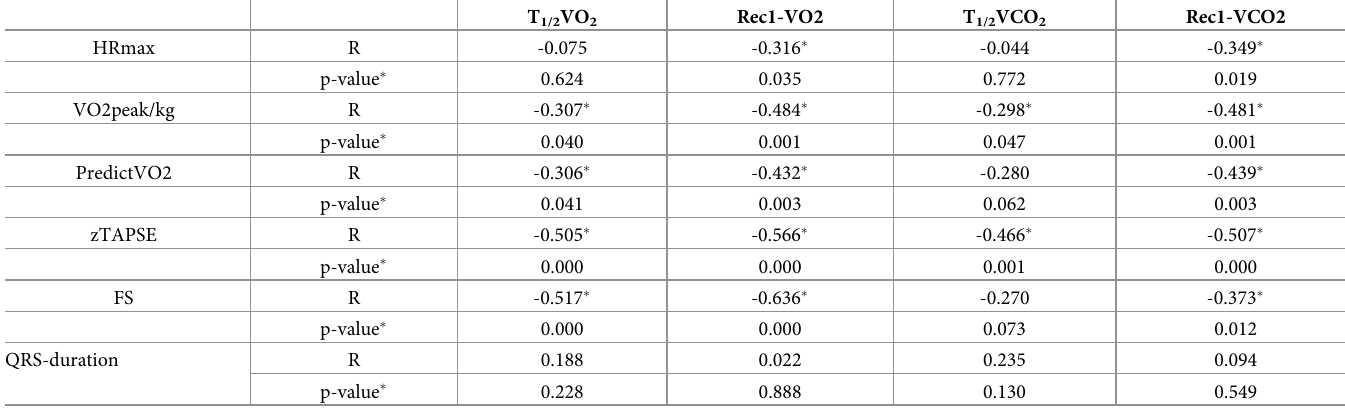
Table 3. Correlations between recovery parameters and exercise tolerance parameters, ventricular function and QRS-duration in rToF patients.